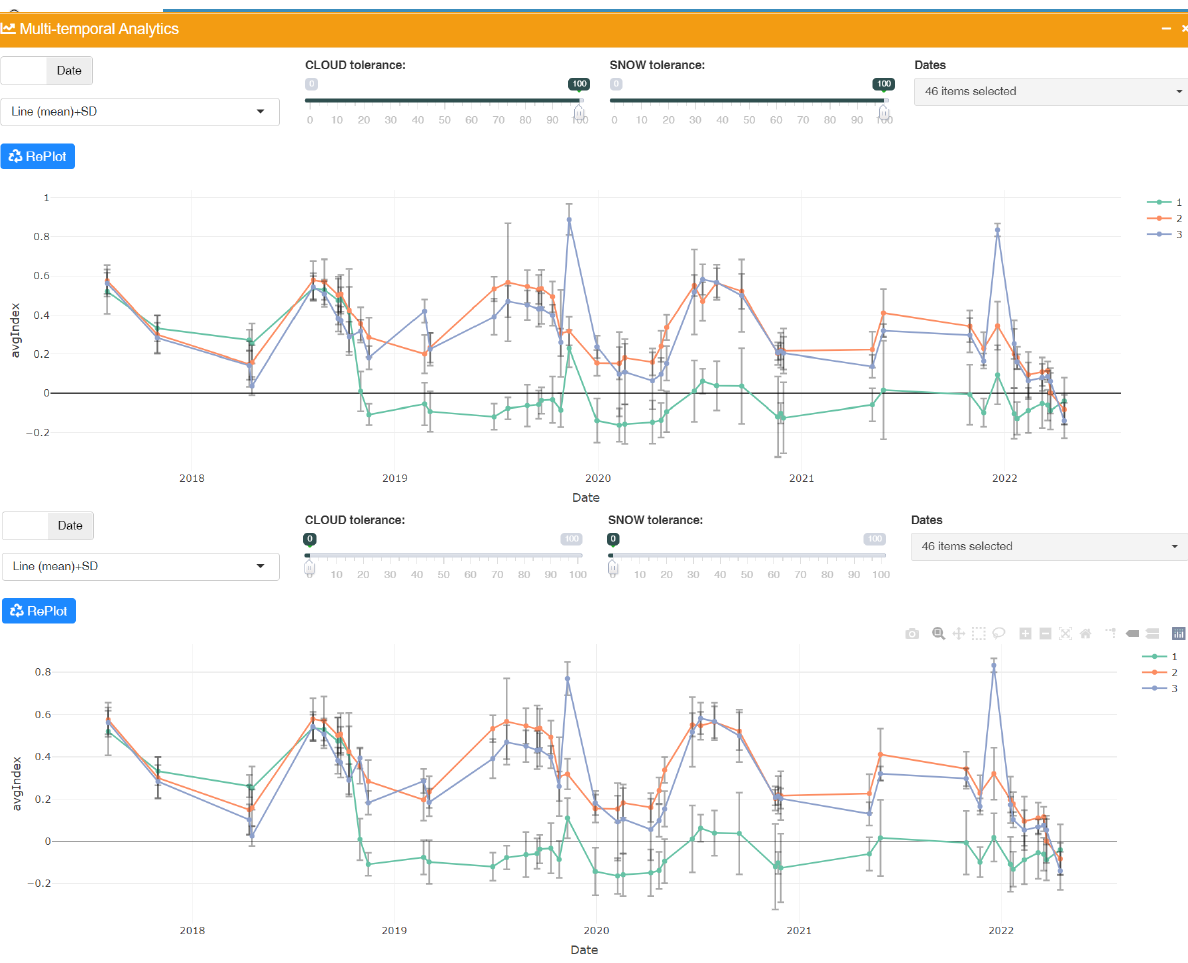
Figure 7. Zonal statistics of three burned areas: 2 and 3 are the areas shown in figure 5, and line 1 is the area of Taibon Agordino that burned the 24th October 2018. The top plot is without filtering cloud/snow, the bottom one is with full filtering of any pixel above zero probability. Notice the different scale in the Y